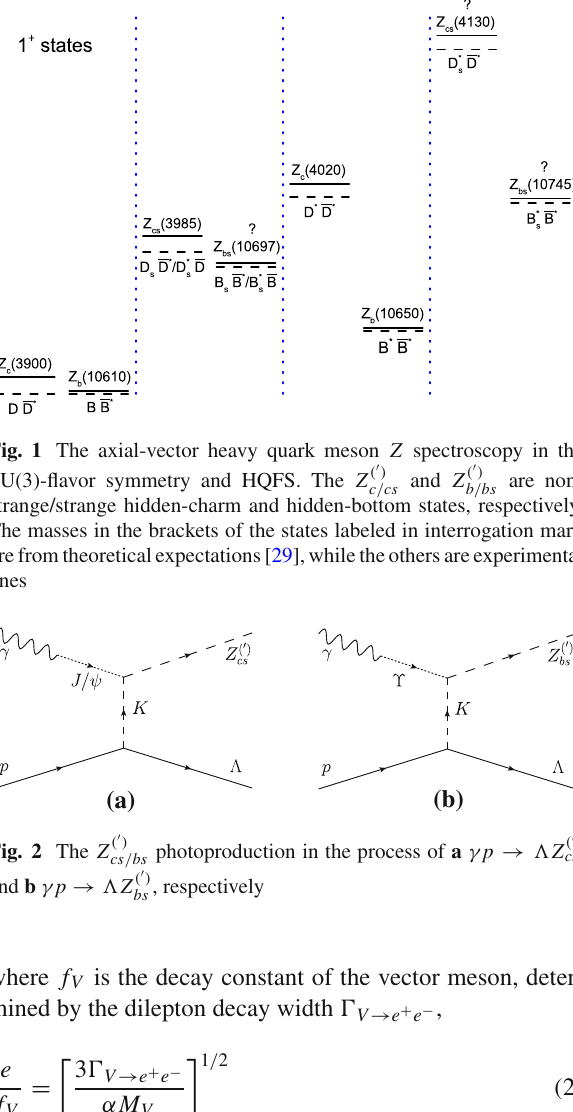
with α = e 2 /( 4 π) = 1 / 137 being the fine-structure con- stant. We obtain f J /ψ = 11 . 16, f ϒ( 1 S ) = 39 . 69, f ϒ( 2 S ) = 60 . 46, and f ϒ( 3 S ) = 72 . 23 with the M V and (cid:11) V → e + e − from the Particle Data Group (PDG) [23]. While the effective Lagrangian for the coupling of N K (cid:3) is taken from Ref.